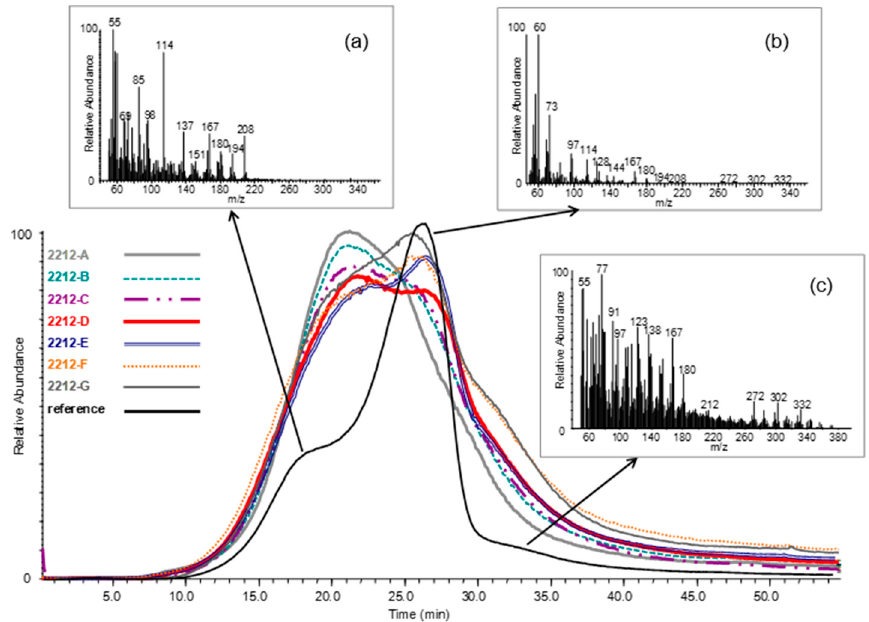
Figure 3. Total ion thermograms (TITs) of sound oak wood (reference) and archaeological wood samples from pile 2212 from “La Marmotta” collected at increasing depths from the surface (A—surface, G—core) and mass spectra extracted from the three thermal degradation regions of sound oak wood. ( a ) Below 300 °C, ( b ) between 300 °C and 400 °C, and ( c ) above 450 °C.